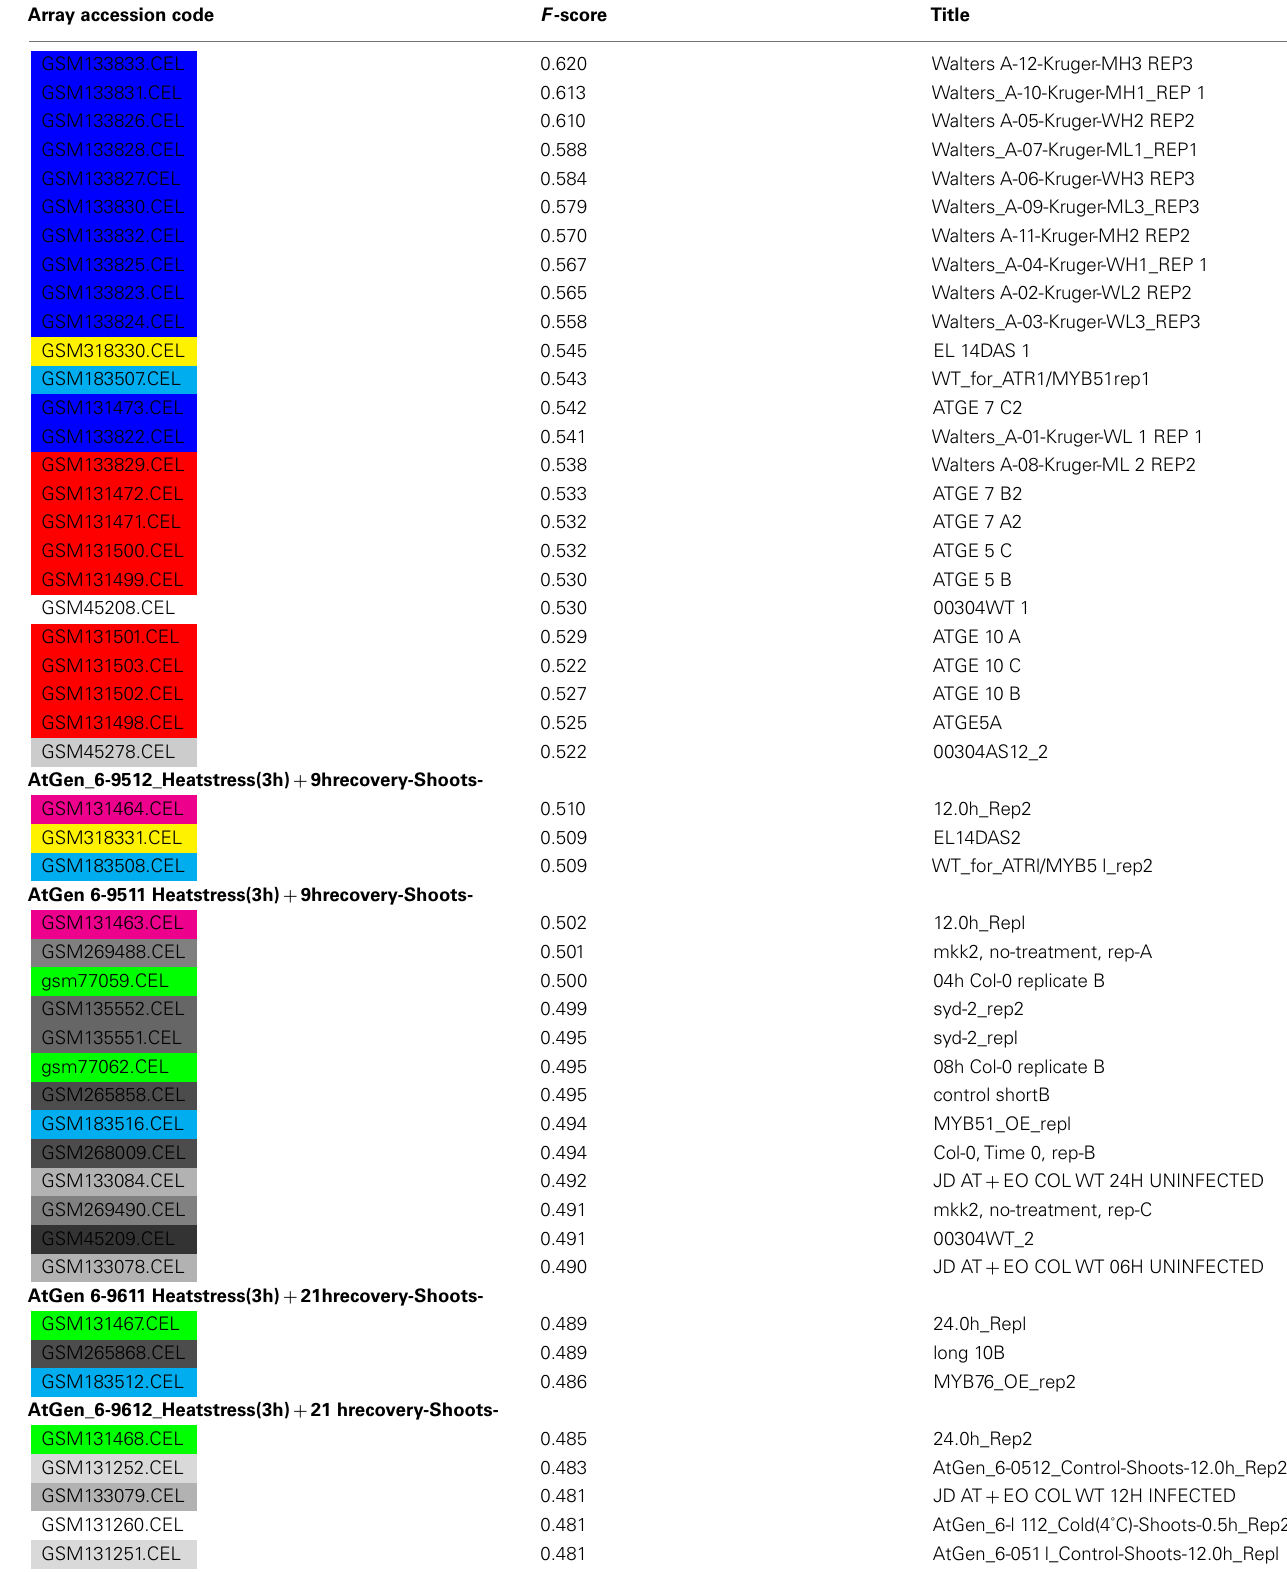
TableA2 |Top ScoringArrays for the